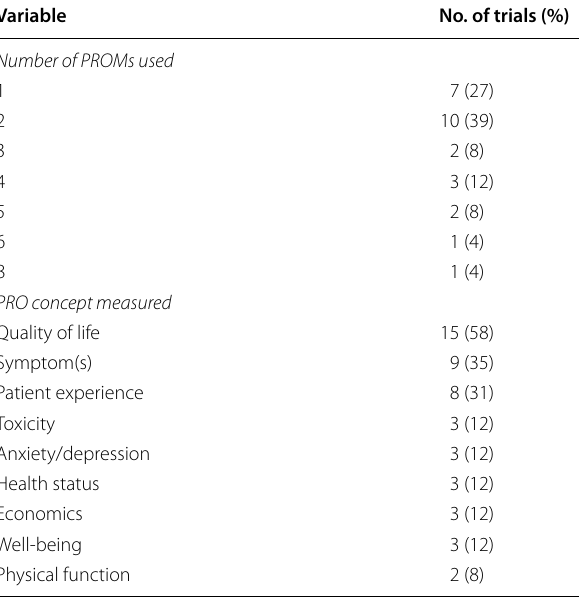
PRO, patient-reported outcome; PROM, patient-reported outcome measure